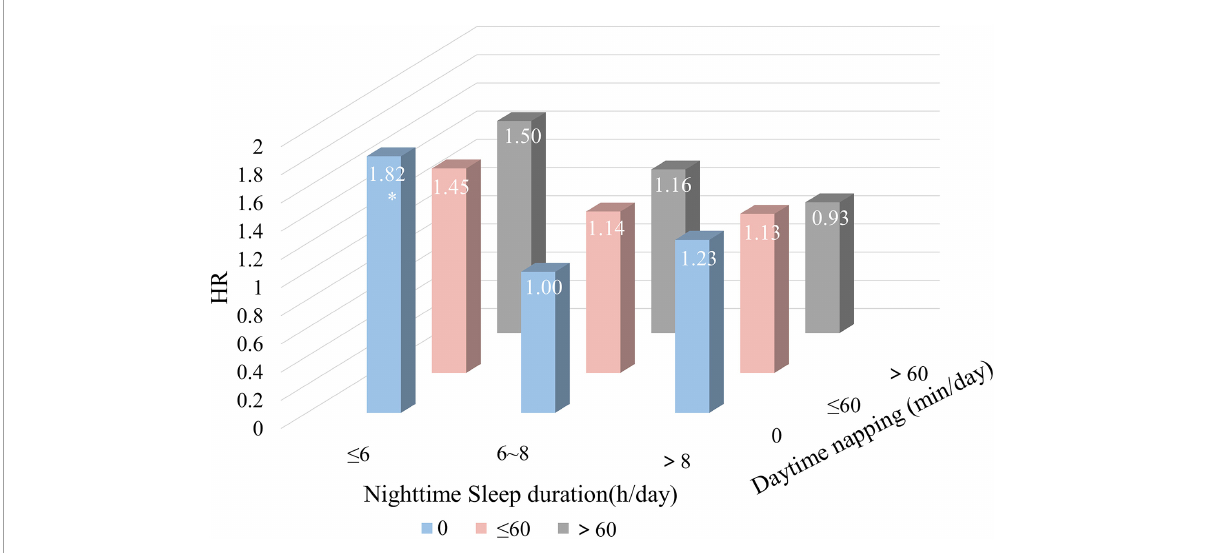
FIGURE3 Combined effects of nighttime sleep duration and daytime napping on the risk of stroke. All hazard ratios were calculated with moderate sleep duration (6 ∼ 8 h/night) and no napping as the reference groups. HR, hazard ratio. * P < 0.05.